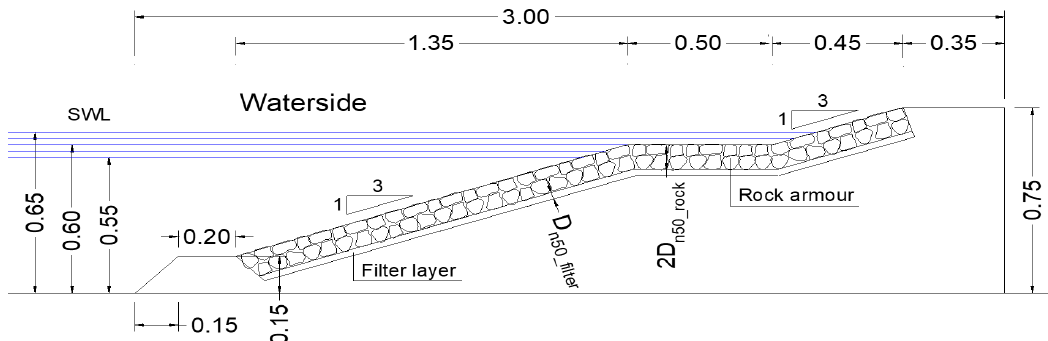
Figure 10. Test configuration (unit: m) of the R3WB tests, with rock armour on the entire slopes with a wider berm (0.5 m) than Model R3 (0.2 m) and the same test conditions as R1N. D n 50_ rock = 5 cm and D n 50_ filter = 2.5